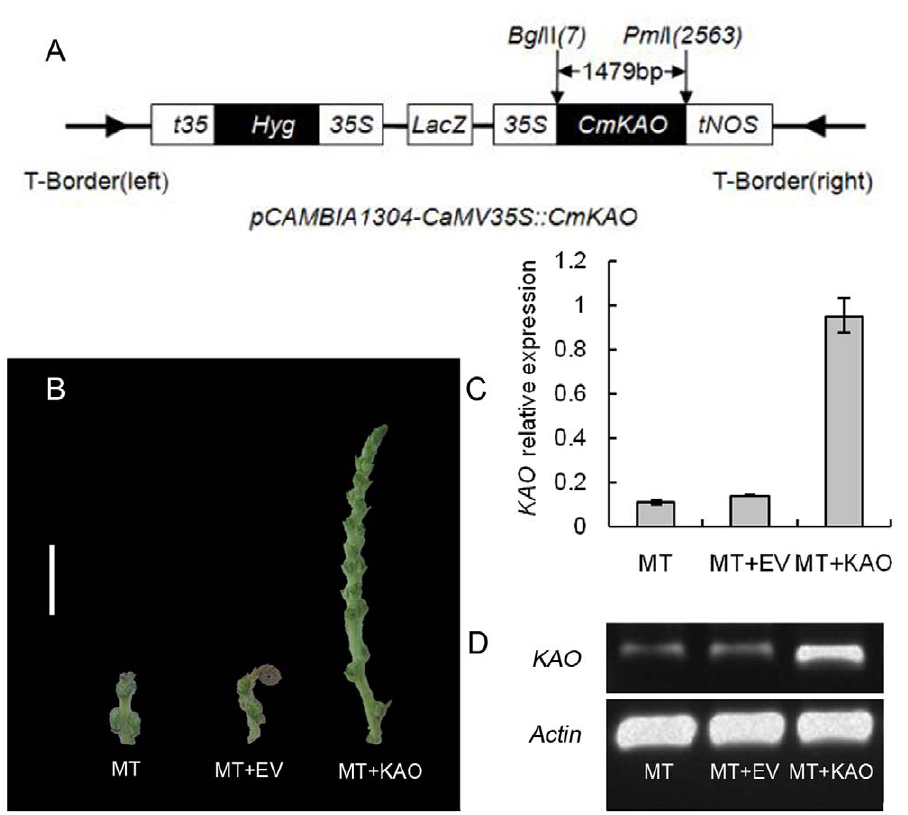
Figure 8. Transient over-expression of CmKAO rescued the short catkins phenotype in sck1 . ( A ) The construct of transforming vector pCAMBIA1304-CaMV35S::CmKAO . The CmKAO coding sequence (1479 bp) is digested with Bgl II and Pml I and cloned into the pCAMBIA1304 vector. ( B ) The phenotypes of MT, MT + EV and MT + KAO in the primordium of the stamen, Bar =1 cm. ( C ) Comparison of relative expression of KAO on MT, MT + EV and MT + KAO. Data are means ( 6 SE, n=3). ( D ) Semi-quantitative RT-PCR analysis for CmKAO transcripts accumulation in MT, MT + EV and MT + KAO. Amplification of actin gene transcript was used as an internal control. The RT-PCR products were resolved on cyanine dye-stained 1.0% (w/ v) TBE-agarose gels and visualized under UV light.